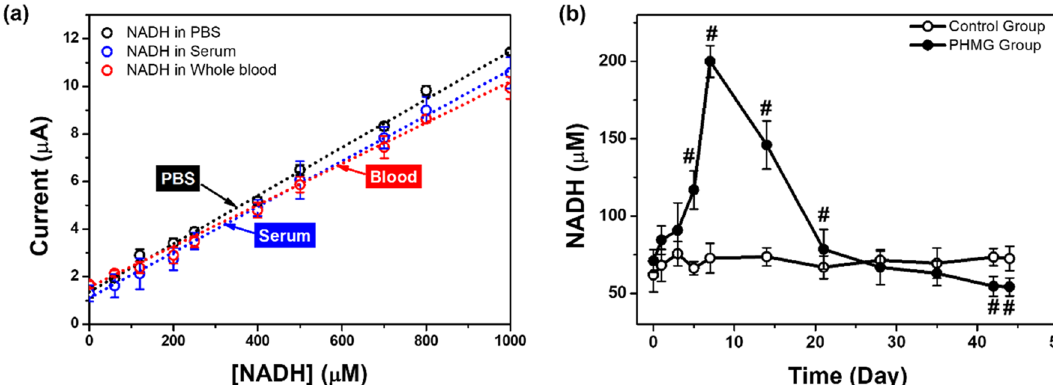
Figure 4. ( a ) Calibration plot for NADH obtained with pure PBS buffer, mouse serum, and blood (n = 5). ( b ) NADH profiles of the control and PHMG-p exposure groups obtained using an electrocatalytic assay (n =